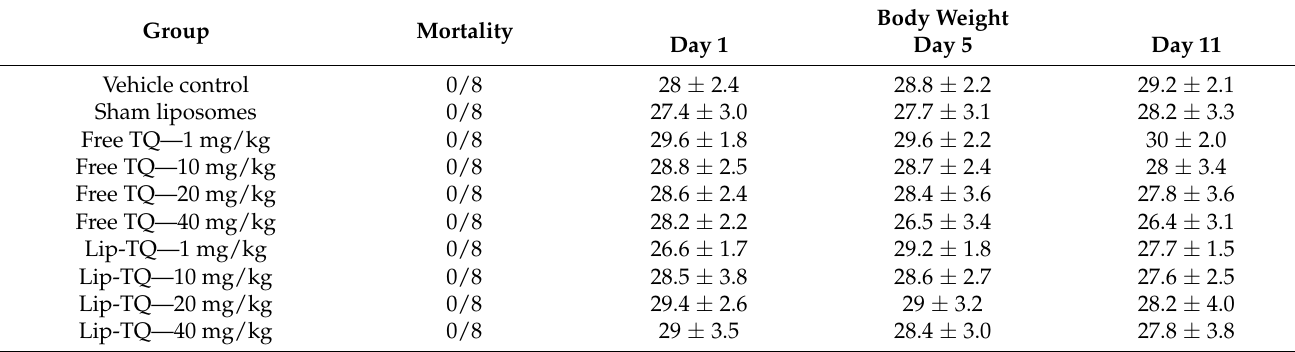
Table 1. Mortality and change in body weight in the mice injected with various doses of free TQ or Lip-TQ. The data are represented as the means ± SD of three independent experiments.